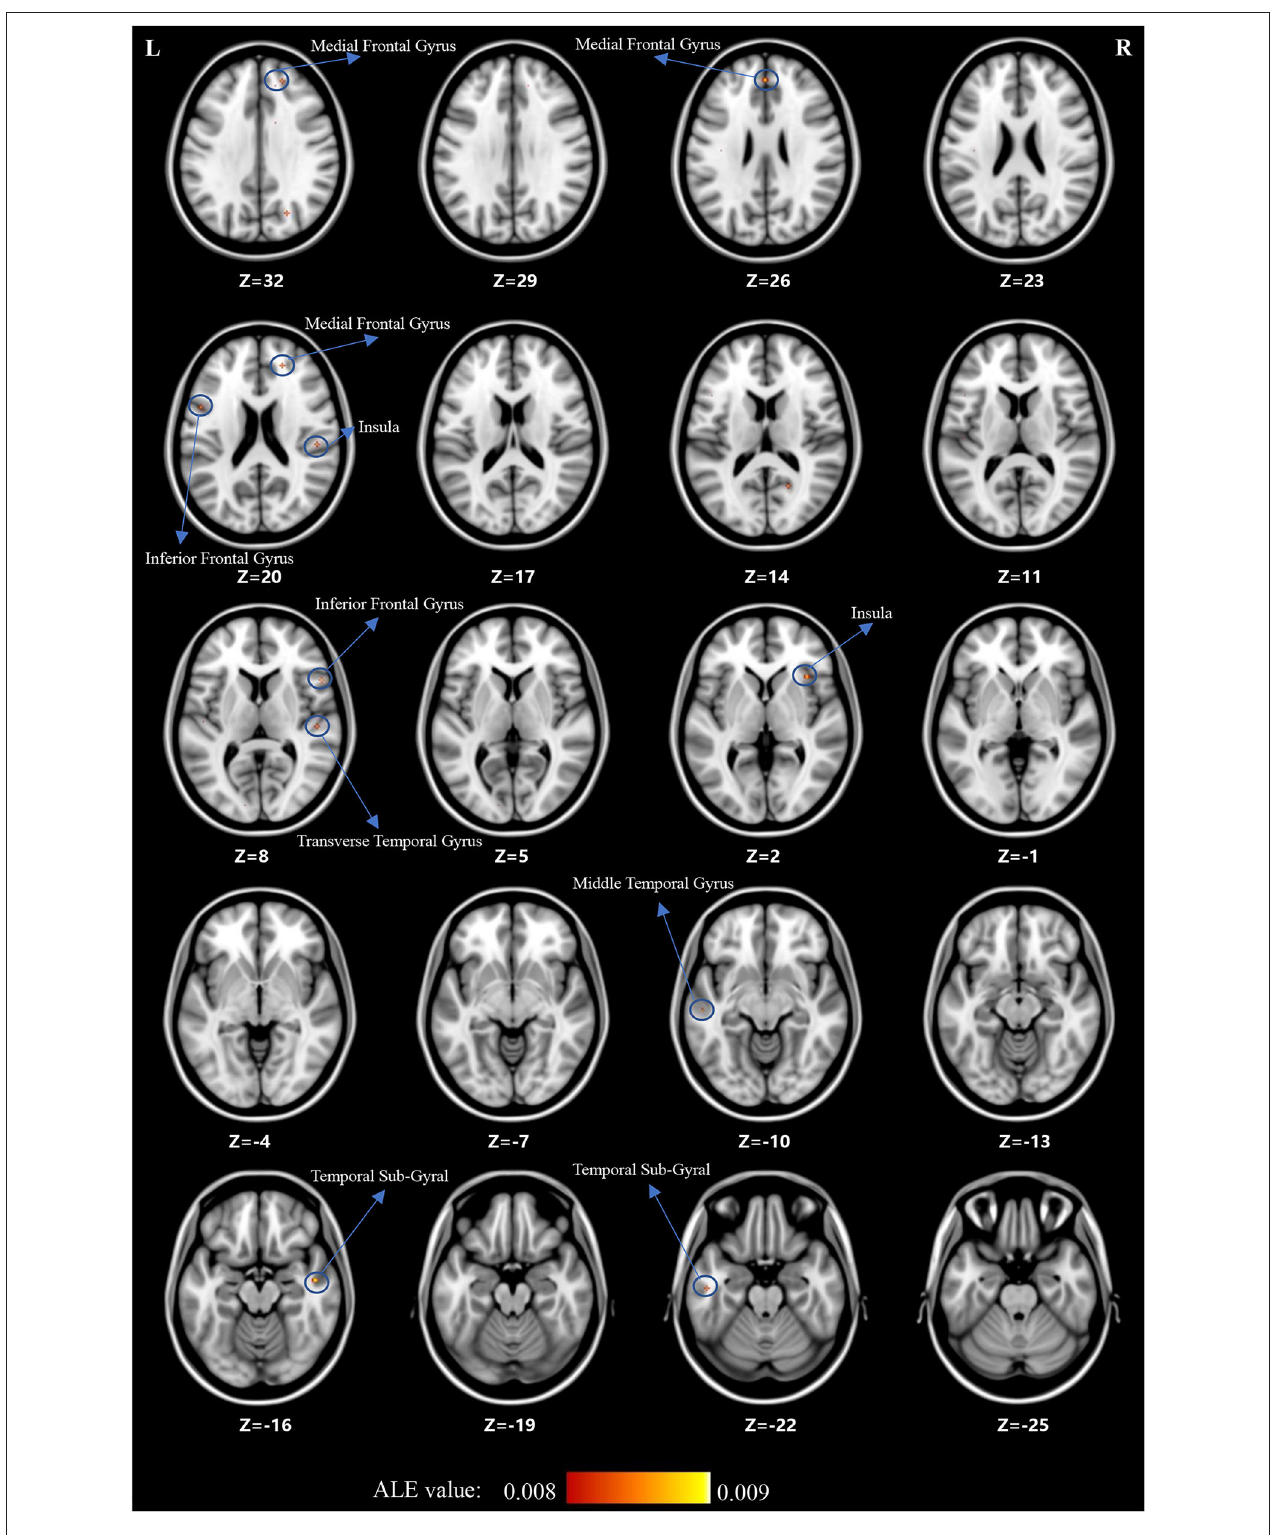
FIGURE 2 | The gray matter reduction (red) in SCZ based on ALE